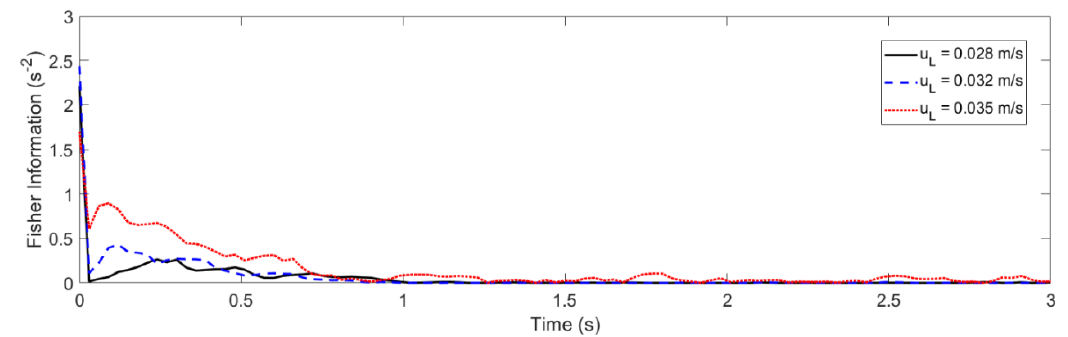
Figure 8. Fisher information as a function of time for the LSFB ( above ) and the GLSFB ( below ).